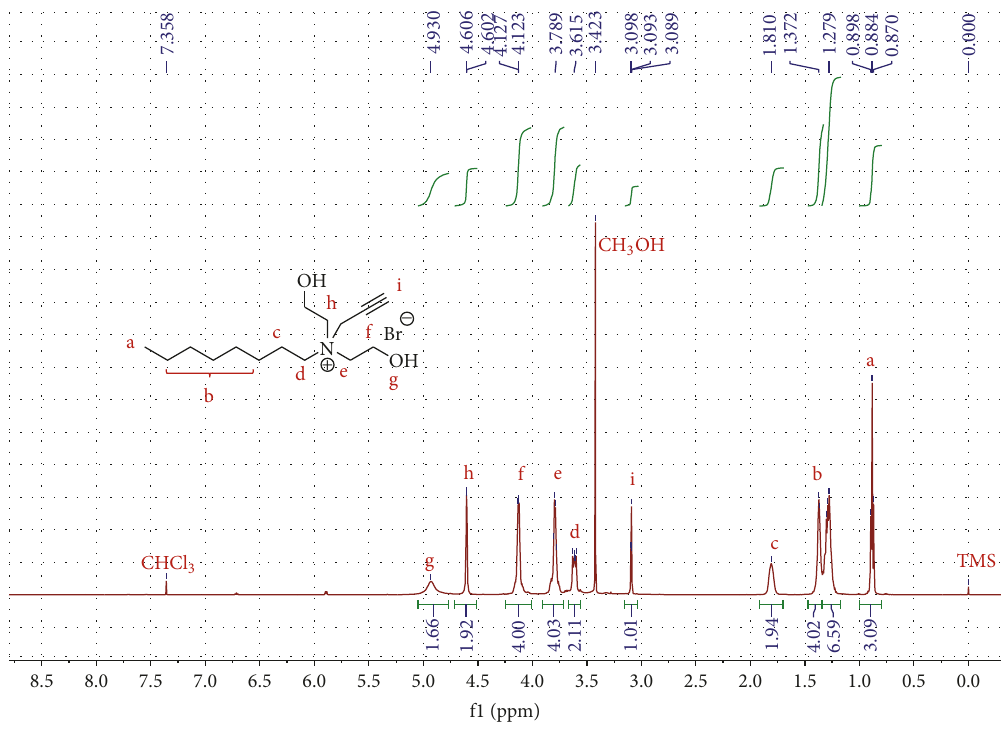
Figure 2: 1 H NMR spectrum of 2b .